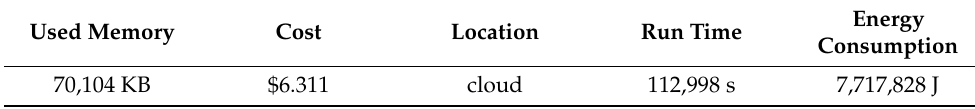
Table 14. Task ID 318037